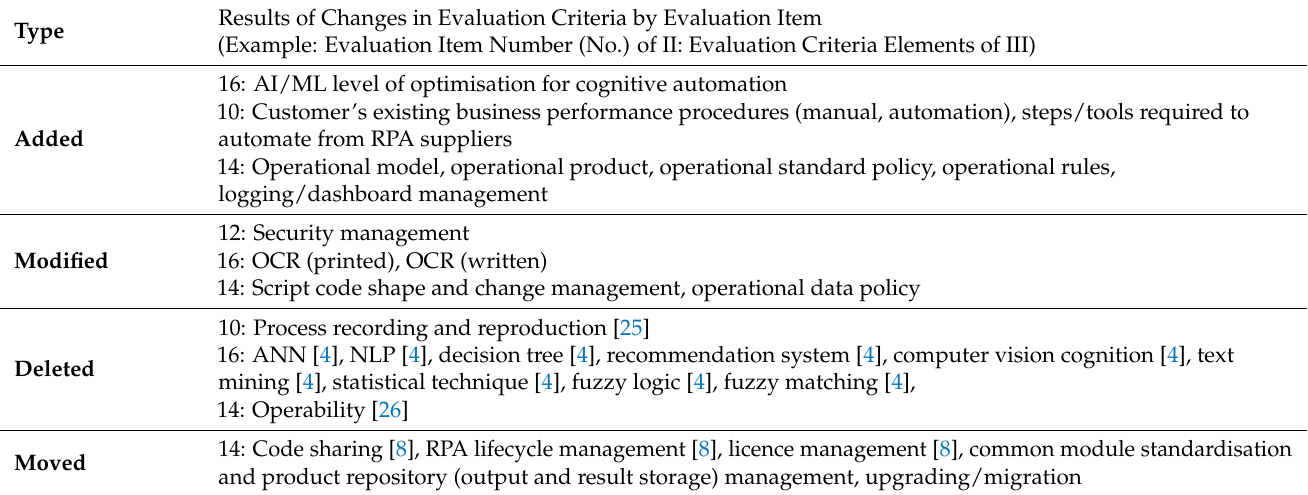
Table 11. Updated selection criteria based on the third Delphi evaluation